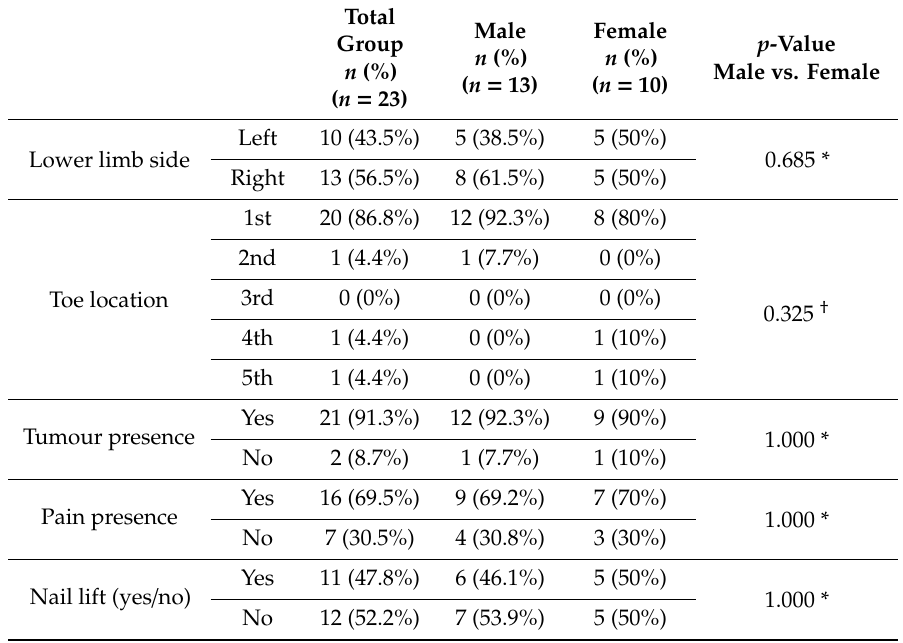
Table 2. Clinical features of the sample population before